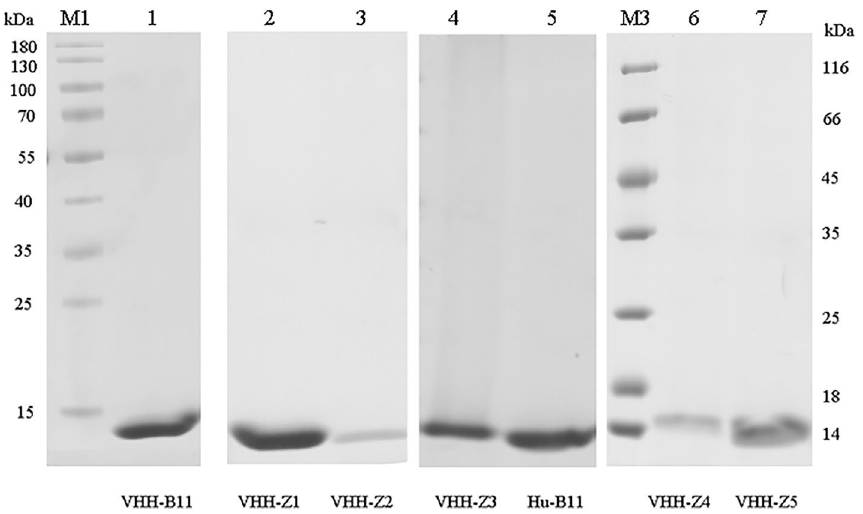
Figure 5. The SDS-PAGE gel of the VHH-B11 humanized antibodies. The SDS–PAGE gel of multiple VHH- B11 humanized antibodies expressed by P. pastoris X33. M1/M3: the protein markers (Fermentas, USA). Lane 1: